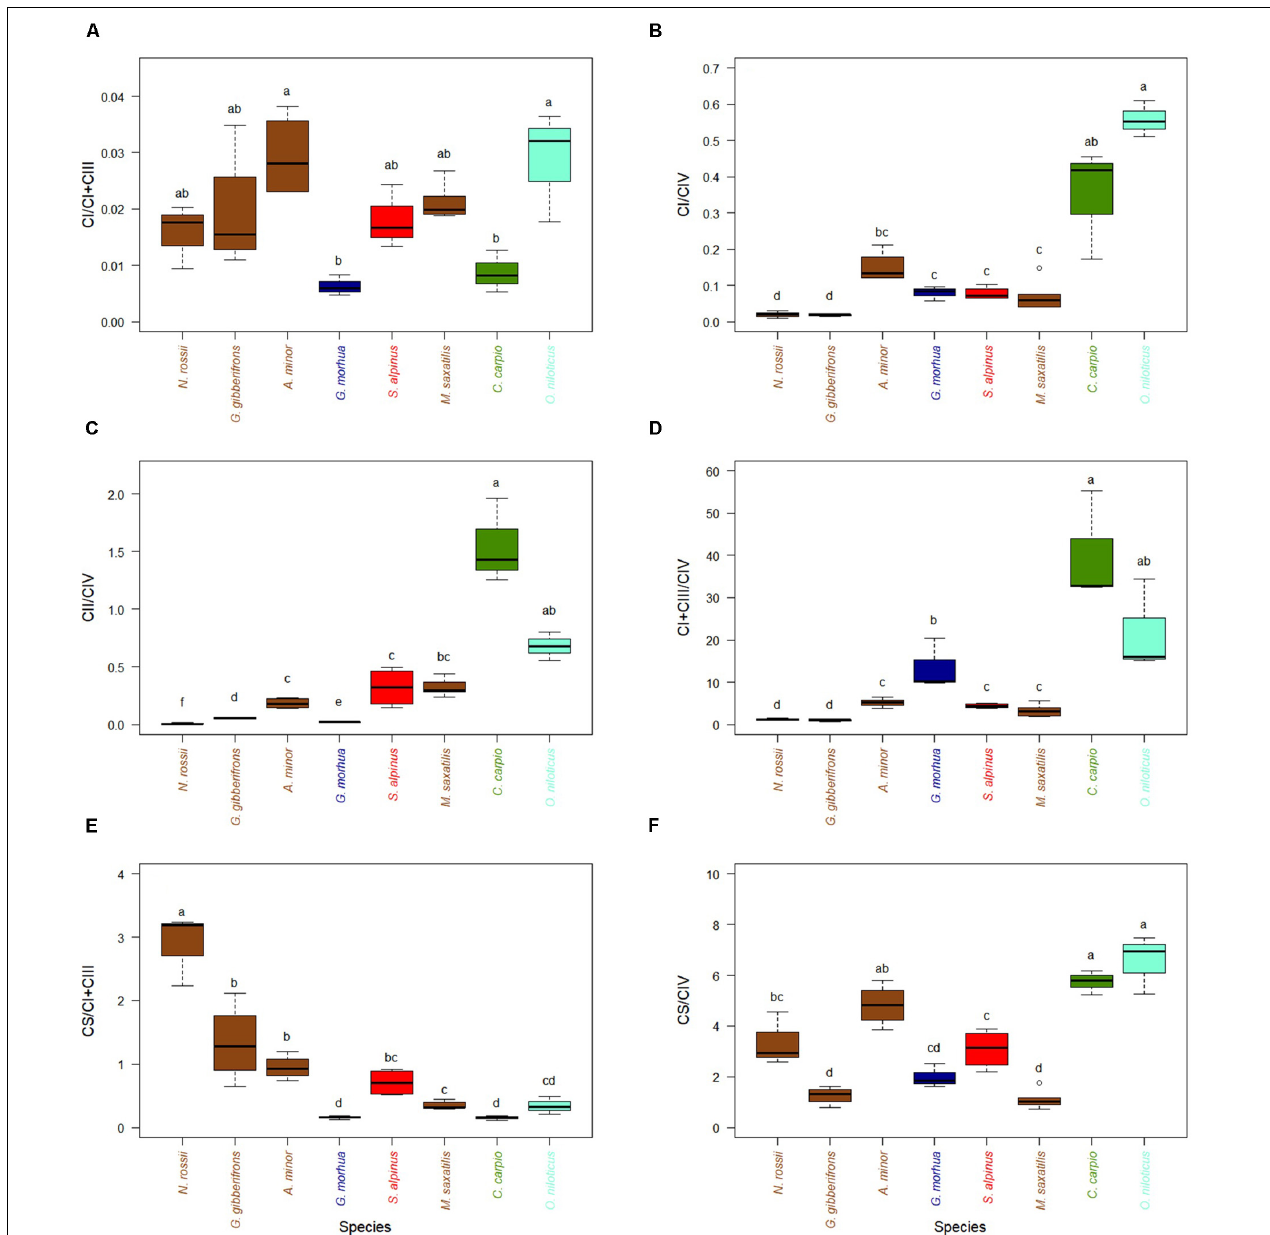
FIGURE 3 | Activity ratios of CS and ETS enzymes in hearts of cold-adapted fish (left), cold-temperate adapted fish and fish species adapted to warmer habitats (right). Enzymes activities were measured at temperature near their thermal optimum. (A) CI activity expressed relative to CI + CIII. (B) CI activity expressed relative to CIV. (C) CII activity expressed relative to CIV. (D) CI + CIII activity expressed relative to CIV. (E) CS activity expressed relative to CI + CIII. (F) CS activity expressed relative to CIV. Values are represented as mean ± SEM. Statistical differences are represented with letters ( p < 0.05). Notothenia rossii ( n = 3). Gobionotothen gibberifrons ( n = 4). Anarhichas minor ( n = 4). Gadus morhua ( n = 3). Salvelinus alpinus ( n = 4). Morone saxatilis ( n = 5). Cyprinus carpio ( n = 3). Oreochromis niloticus ( n = 3). Brown boxes represent Perciformes, dark blue Gadiforme, red Salmoniforme, green Cypriniformes, and light blue is